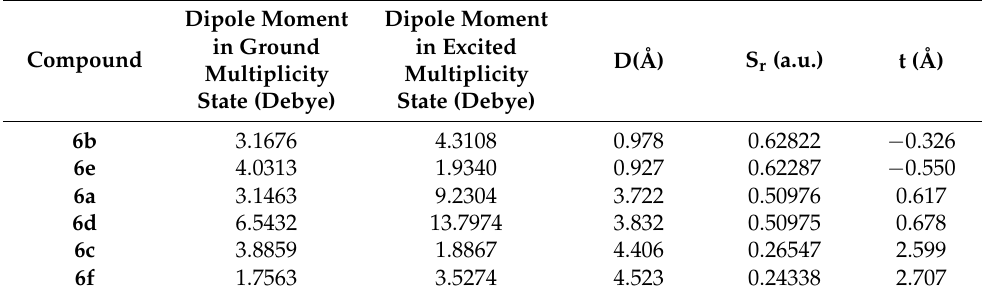
Table 6. Calculated dipole moments for model structures in ground and excited multiplicity states and estimated indexes related to hole-electron distribution (CT-indexes). Dipole Moment Dipole Moment in Excited in Ground Compound Multiplicity Multiplicity State (Debye) State (Debye)